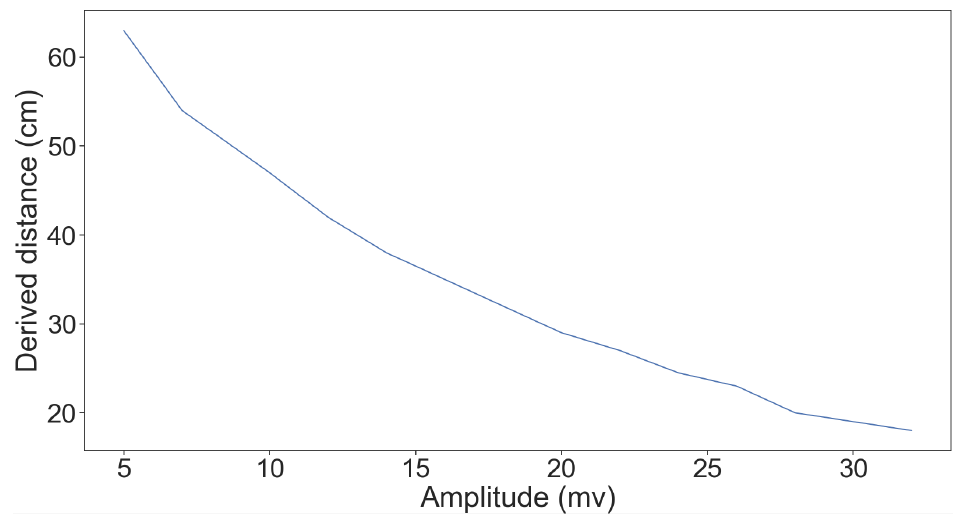
Figure 6. Changing the volume (attacker transmitter amplitudes) when the frequency is fixed (40 kHz). The sensor is 1.7 m from the object. In can be seen that as the strength increases, the perceived (measured) distance